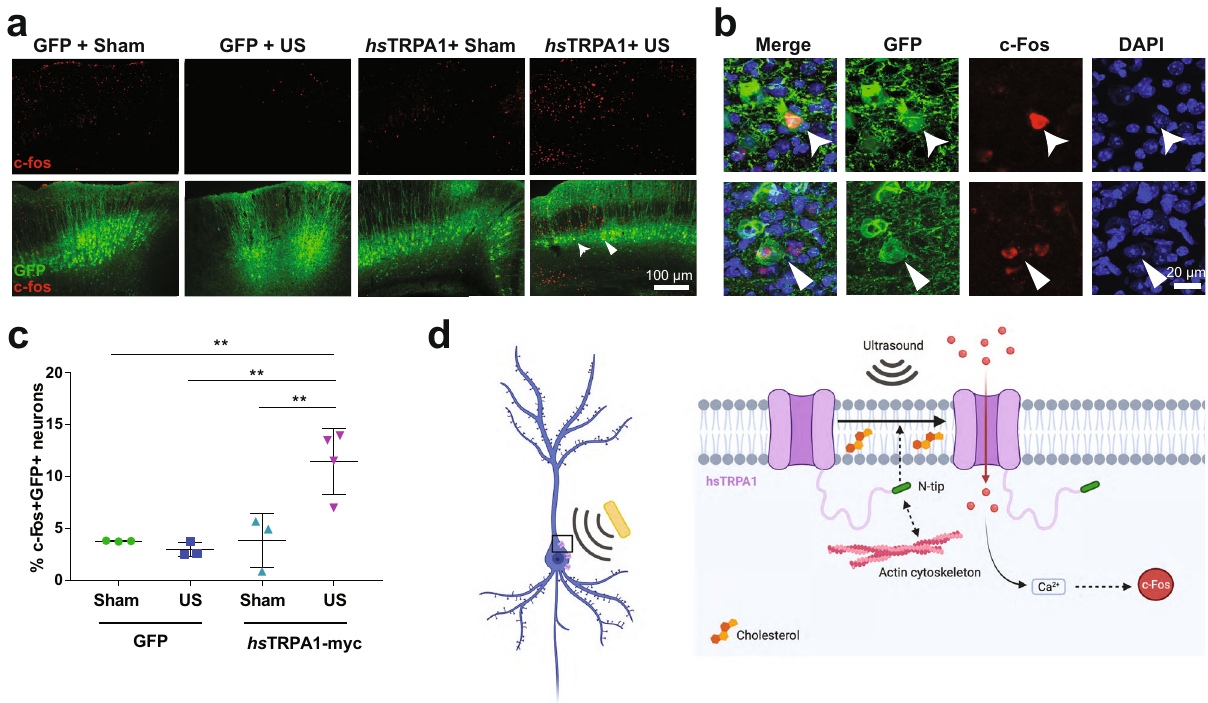
Fig. 6 hs TRPA1 enables ultrasound-triggered c-fos activation in vivo. a Representative images from sections taken at ~700 μ M intervals throughout the GFP + region of the cortex with c-fos staining. Expression of c-fos and GFP were quanti fi ed across all sections with positive GFP immunolabeling in each animal. Zoomed images showing co-localization of b , c-fos and GFP and c-fos and DAPI within GFP positive neurons. c Quanti fi cation of c-fos positive, GFP + neurons in different experimental groups, after ultrasound stimulation. Data are mean + - SEM, n = 3 – 4 biologically independent animals/group ** p < 0.01 compared to GFP control by two-way ANOVA followed by Tukey ’ s multiple comparisons. Source data are provided with this paper. d Proposed model of action of hs TRPA1 in neurons, illustrating requirement of the N-terminal tip, actin cytoskeleton, and cholesterol to induce an ultrasound- dependent increase in intracellular calcium resulting in neuronal activation and c-fos